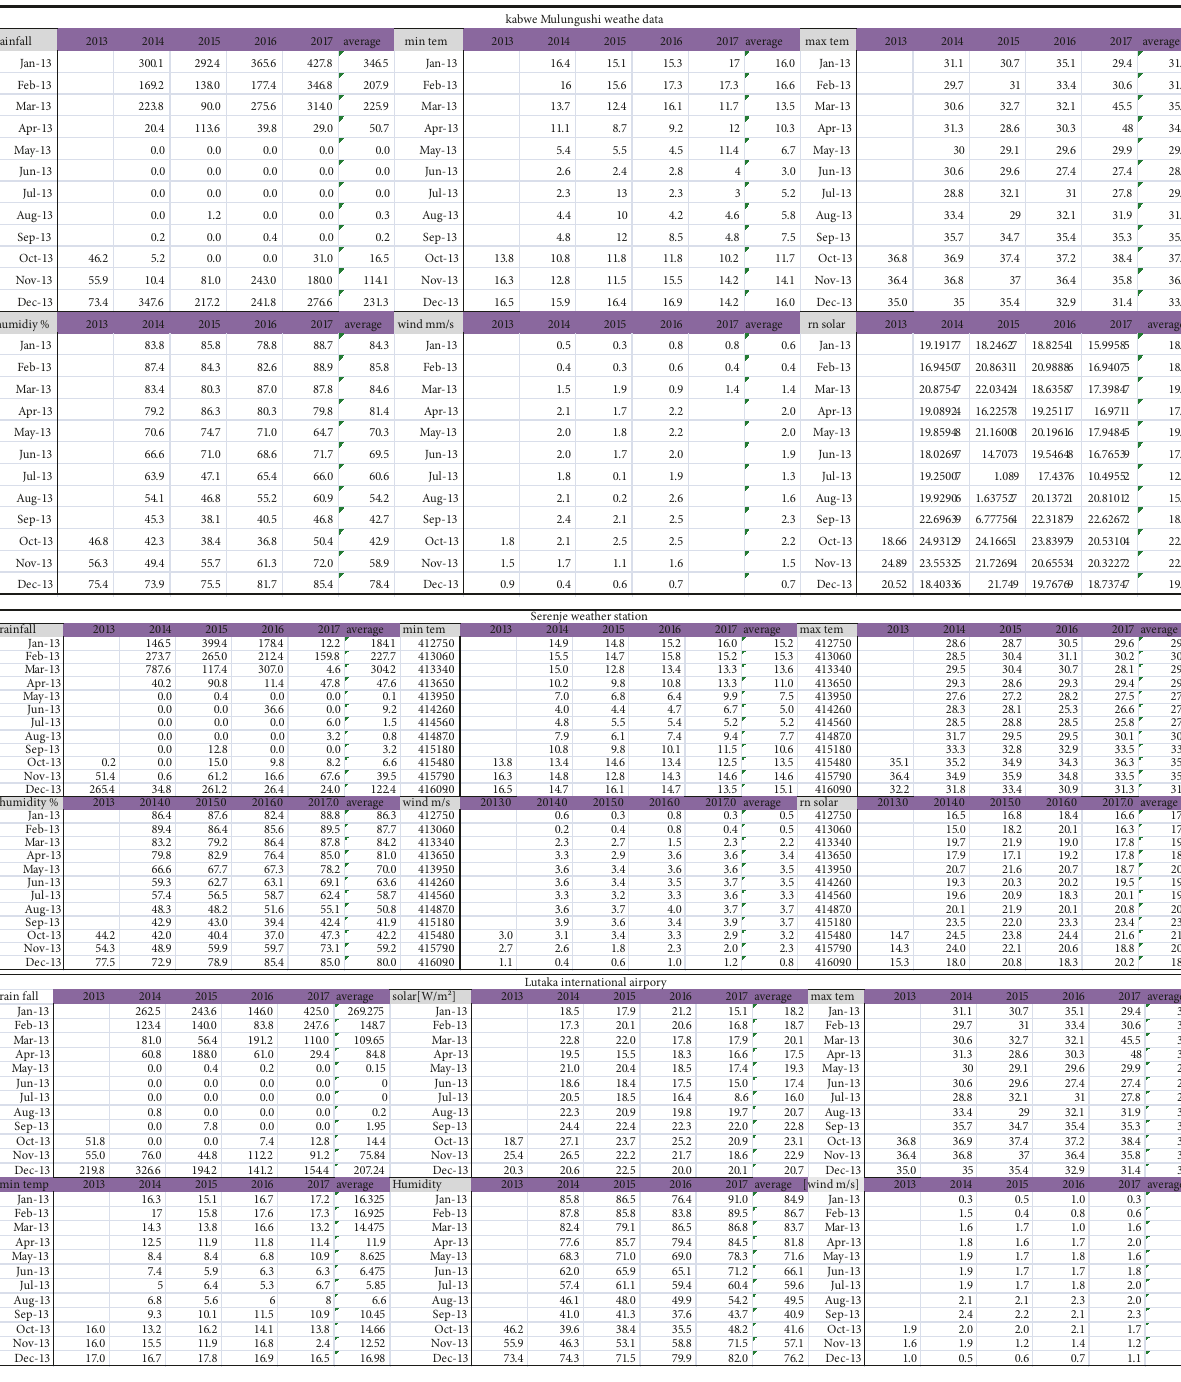
Figure 8: Weather data from Serenje, Kabwe, and Lusaka airport